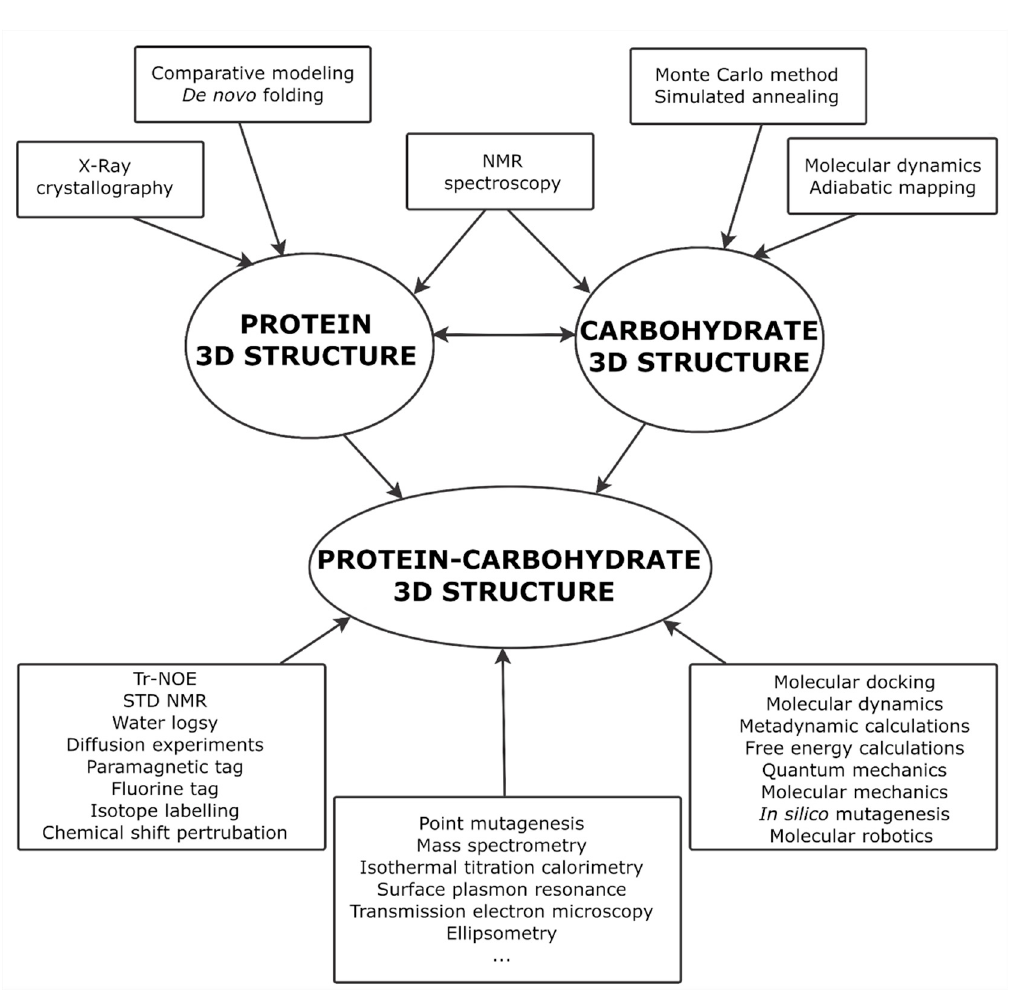
Figure 6. Interplay of the instrumental and computational methods in the 3D structure determination of carbohydrates, proteins, and protein–glycoconjugate complexes. Reproduced from [285] © 2020 The authors. Published by Wiley-VCH Verlag GmbH & Co. KGaA.